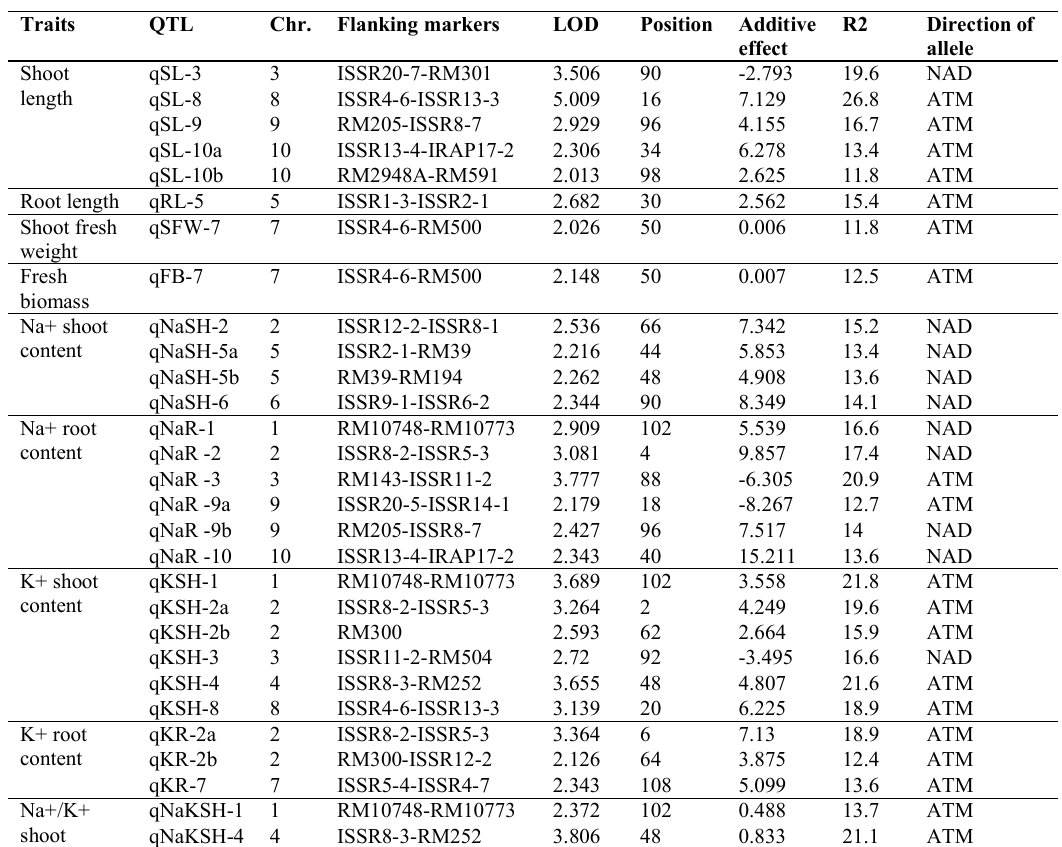
Table 1. Putative QTLs for salt tolerance in the seedling stage the F8 population derived from Ahlemi Tarom*.